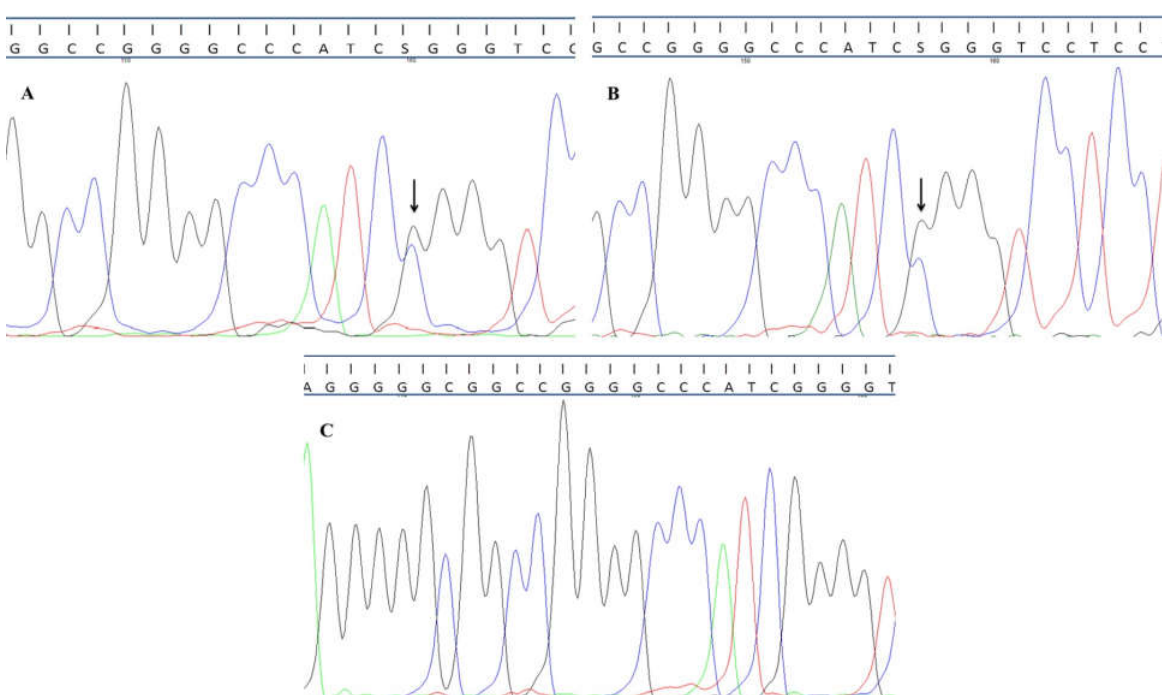
Fig. 1. Electropherogram profiles of TJP2 gene in this family: Segregation analysis TJP2 gene for patient (A); His mother (B); Father (C); The arrows in both figures A and B show the same mutation in patient and his mother; but no such a mutation is detected in his father.